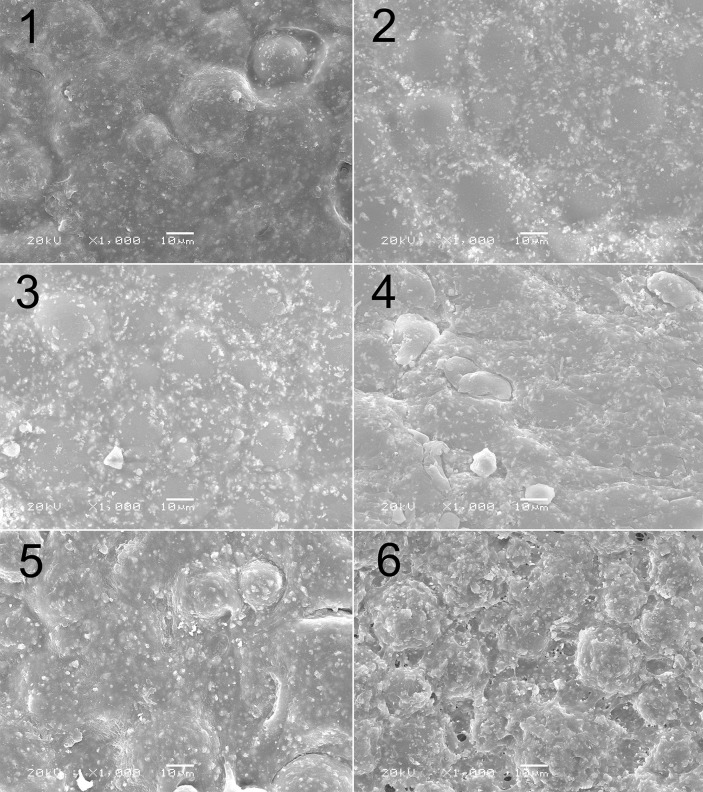
Scanning electron micrographs showing microstructures of various samples.